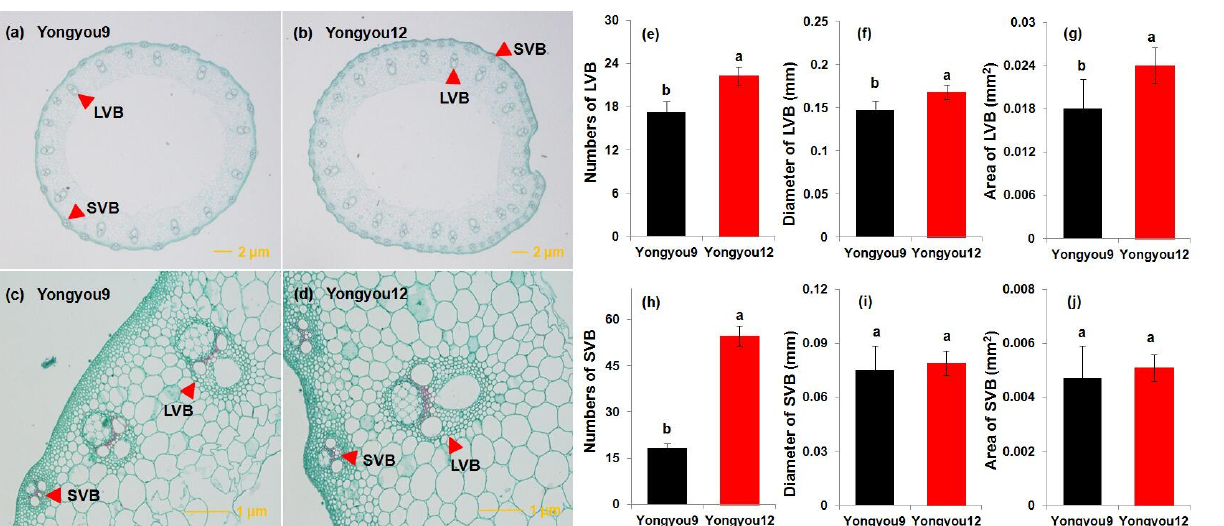
Figure 11. Amount of bleeding sap collected from rice roots after flowering. Error bars denote ± standard deviation ( n = 3).